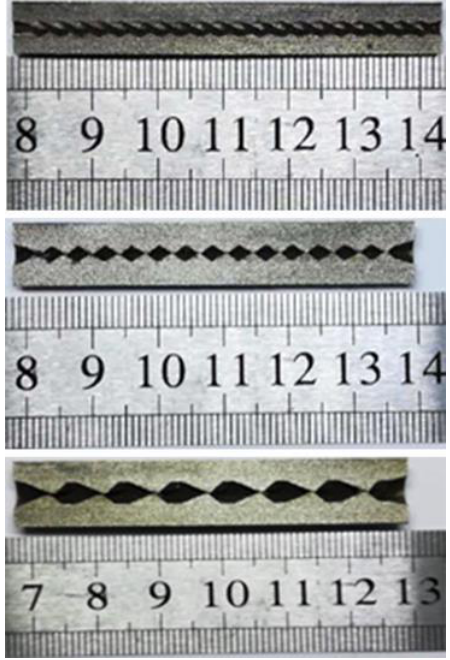
Figure 13. Cross-section of the other micro reacting pipes with different internal structure.